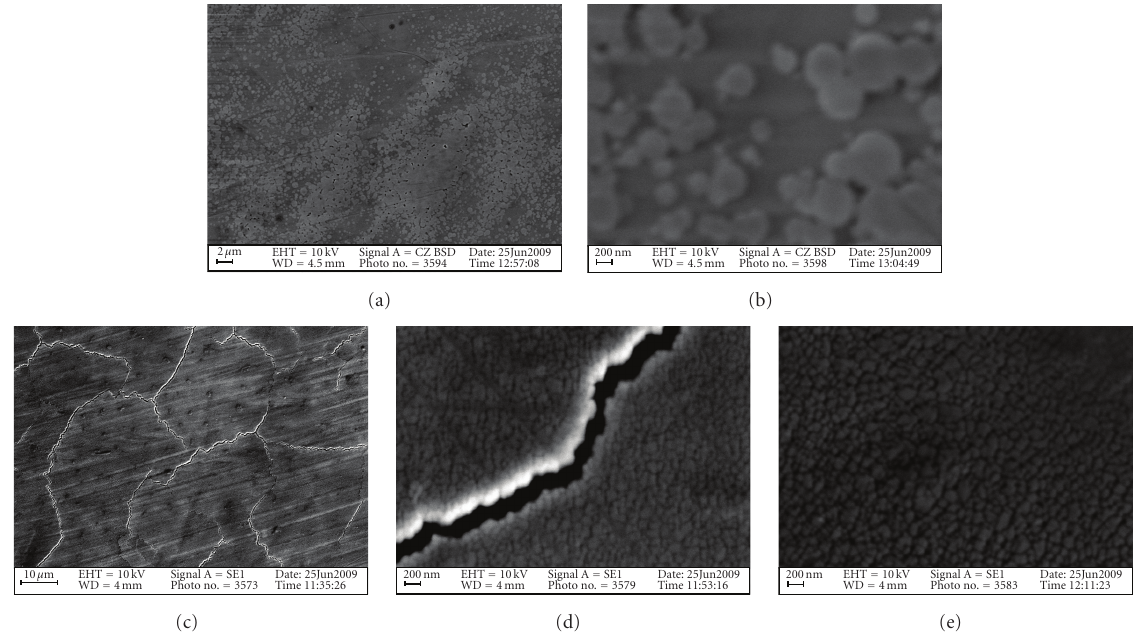
Figure 4: SEM images of the TiNi specimen surface after electron beam irradiation: with E 1 = 4J/cm 2 , N = 20 pulses in backscattered electrons (a), (b) and with E 2 = 8J/cm 2 , N = 50 pulses in secondary electrons